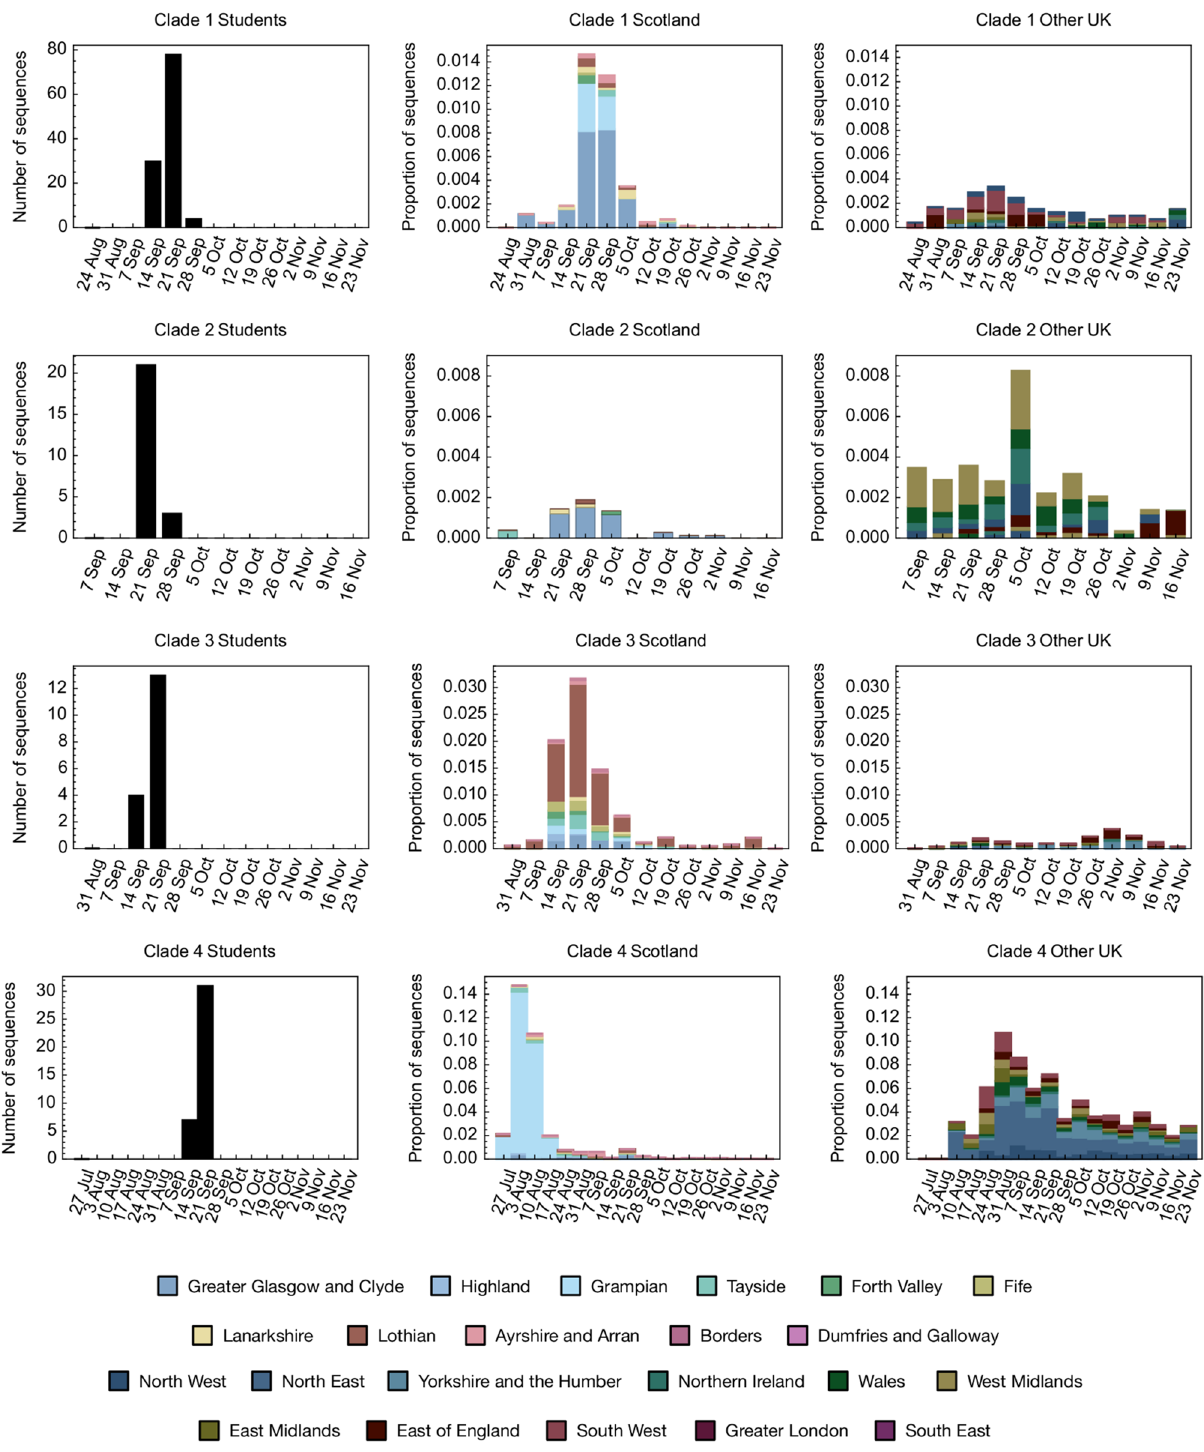
Figure 3. Potential origins of major SARS-CoV-2 clades identified in the University of Glasgow (UoG) student population. Numbers of UoG student sequences associated with each major clade (left column) are shown alongside data describing the associated UK-wide clades. Figures show the proportion of SARS-CoV-2 sequences collected each week in Scotland (middle column) and in the rest of the UK (right column) that were associated with each student clade, coloured by the regions in which the clade-associated sequences were collected. Total numbers of sequences informing this analysis were as follows: Clade 1 n = 412; Clade 2 n = 255; Clade 3 n = 541; Clade 4 n =